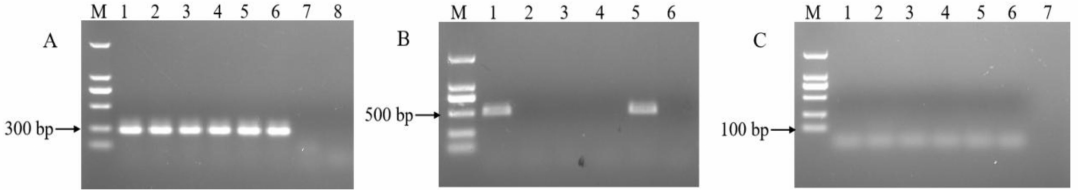
Figure 3. PCR products obtained from genomic DNA of representative root-knot nematode popu- lations isolated from the infested dragon fruit roots. ( A ) Amplification product (293 bp) with the specific primer pair MeF/MeR. M = 2 kb DNA marker; Lanes 1–7 = populations from galled roots collected in Ledong; Lane 8 = negative control. ( B ) Amplification product (517 bp) with the specific primer pair MjF/MjR. Lanes 1–5 = populations from galled dragon fruit roots collected in Ledong (1) and Qionghai (2–5); Lane 6 = negative control. ( C ) No amplification product with the spe- cific primer pair MiF/MiR. Lanes 1–6 = populations from galled roots collected in Ledong; Lane 7 = negative